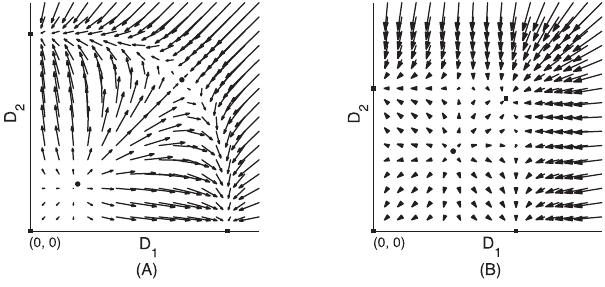
Figure 2. Illustration of adaptation in the phase plane. Squares denote the stable equilibrium states. Arrows starting at point D 1 , D 2 ð Þ stand for the rate of change of the two diameters. (A) phase plane of a parallel vessel system. In the three stable equilibrium states, at least one diameter is zero, i.e., at most one vessel can survive. (B) phase plane of a parallel system with switches (fixed OTRs). There is a new stable equilibrium in which neither diameter vanishes, i.e., both vessels survive.